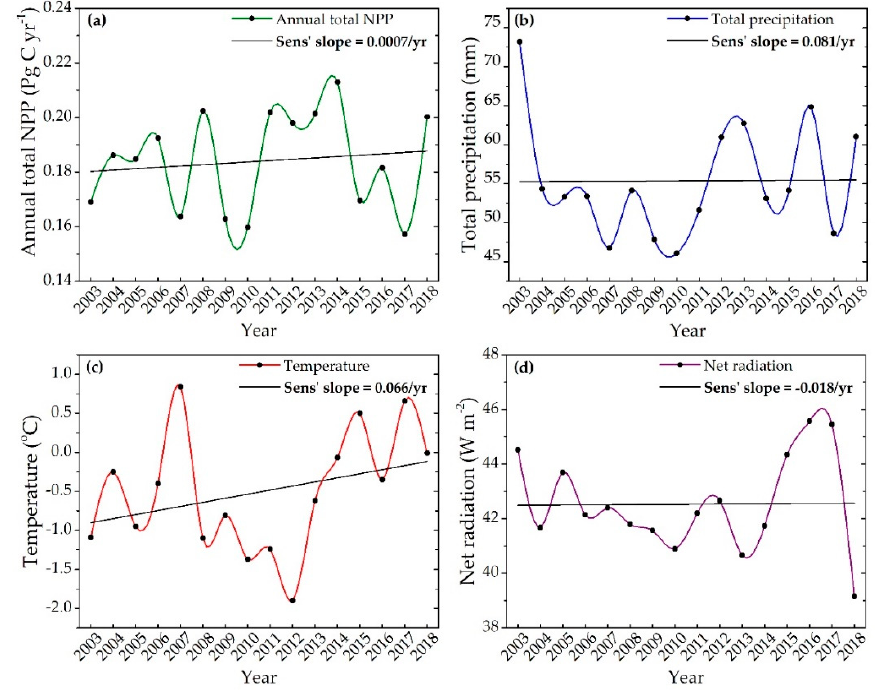
Figure 5. Annual changes in ( a ) NPP, ( b ) total precipitation, ( c ) the mean annual temperature, and ( d ) net radiation across Mongolia.